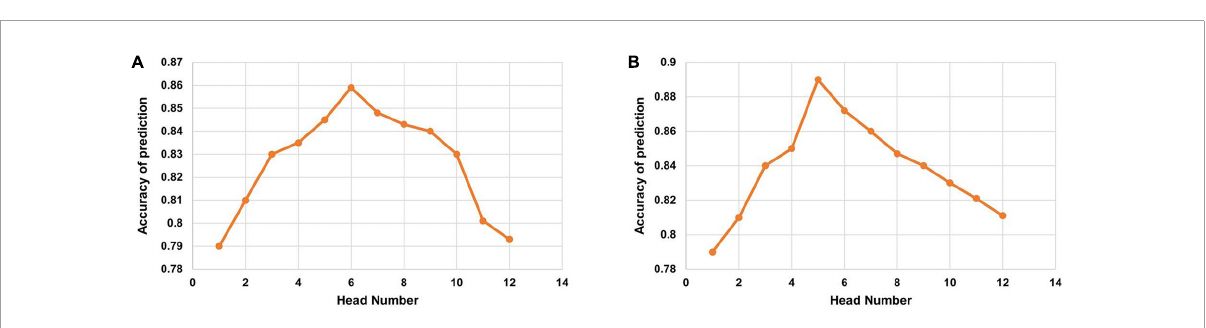
FIGURE5 Accuracy of the multi-head attention with the varying head number on (A) diabetes mellitus (DM) datasets and (B) Alzheimer’s Disease Neuroimaging Initiative (ADNI) datasets.